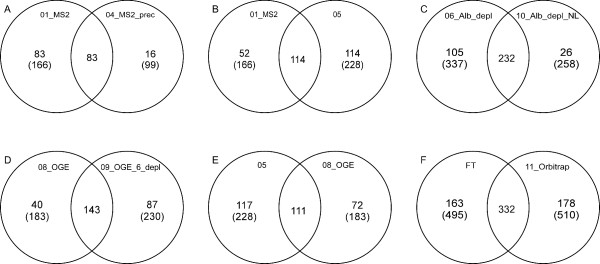
Venn diagram representations of comparisons between pairs of individual plasma experiments. Individual experiments are represented by circles, with compared experiment pairs being depicted by overlapping sets of two circles. The number of proteins identified in both members of a compared set of experiments is given in the intersection region of the circles. The number of proteins that are unique to an individual experiment is shown outside of the intersection region, along with the total number of proteins identified for that individual experiment, shown in parentheses. The plasma experiment represented by each circle is represented at the top of the respective circle, outside of the intersection region (panel A, for example, shows a comparison of experiments 01_MS2, designated "01'', and 04_MS2_prec, designated "04''). The experimental conditions used in each experiment can be found in Table 1. Panel F shows a comparison between all 7 experiments performed on the FT and the last experiment which was performed on the Orbitrap.